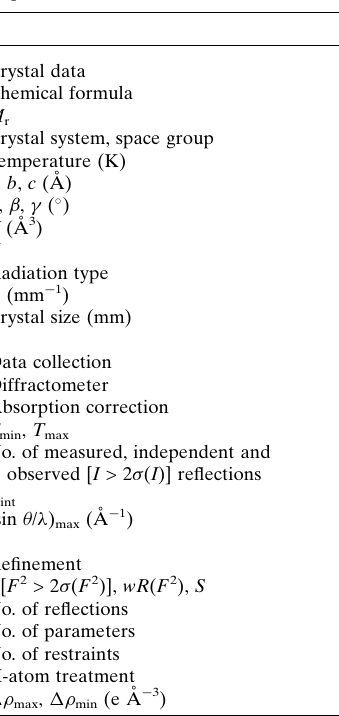
Table 1 Experimental details.